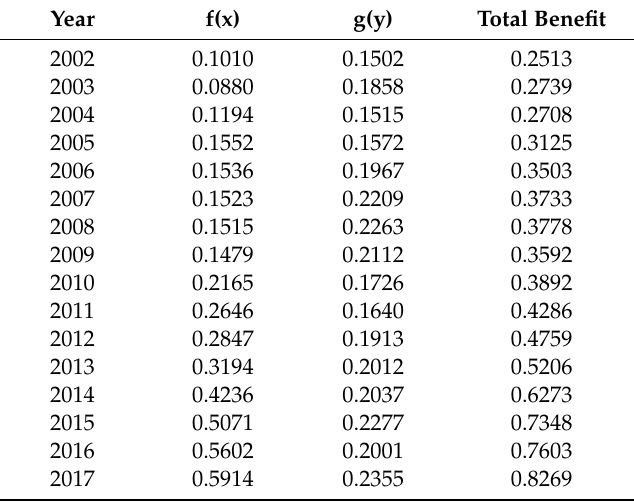
Table 4. The comprehensive evaluation values of the socioeconomic and ecological environment benefits of land